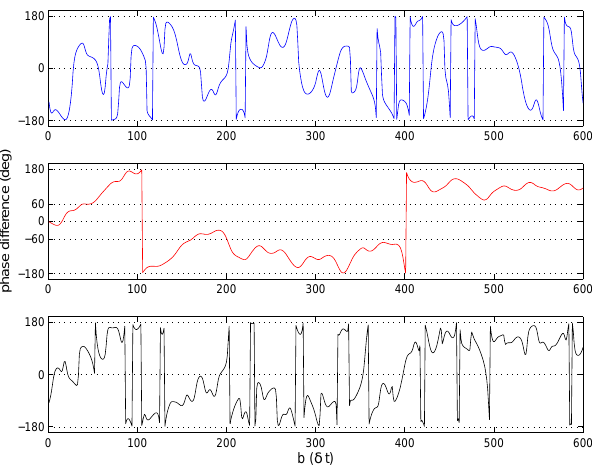
Fig. 2. Phase angle of the wavelet cross spectrum, φ(a,b) Figure 2: Fig. 2 ( φ ∈[− π,π ] ), of two simulated signals given by Eq. (11) at 6Hz (blue), 8Hz (red), and 10Hz